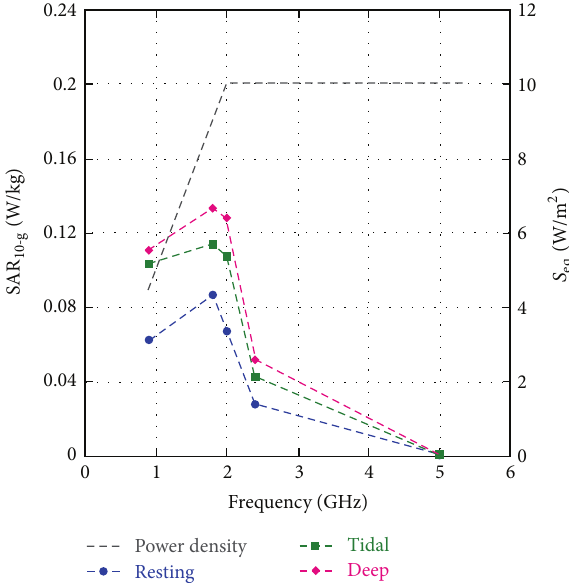
) for the RS model at 900 MHz (a) and at 5000 MHz (b). W / kg